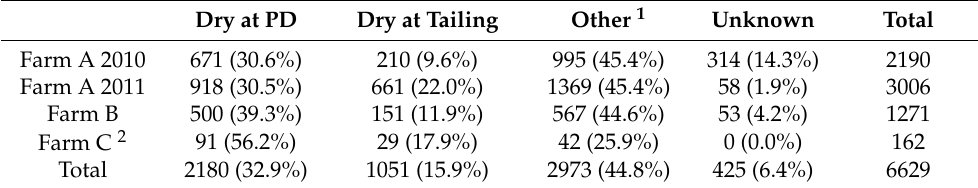
Table 2. Lifetime wastage due to premature culling: of the ewes that were prematurely culled from their respective cohorts, for each cohort the number (and % of those that were prematurely culled within that cohort) that were recorded as culled for each reason, and the total across all study cohorts.